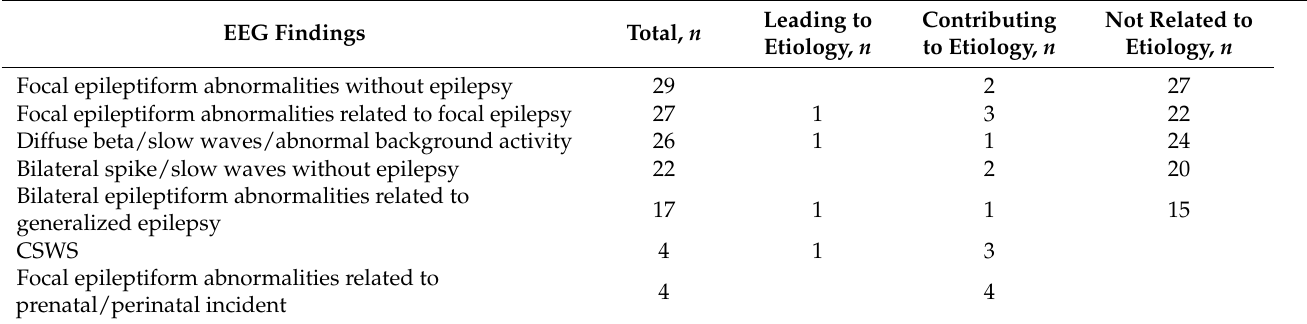
Table 5. Abnormal EEG findings categorized as findings leading to etiology, contributing to etiology, and not related to etiology